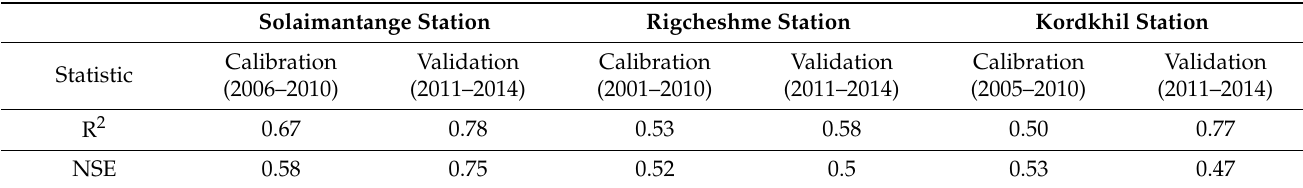
Table 3. Model evaluation statistics for calibration and validation of runoff.